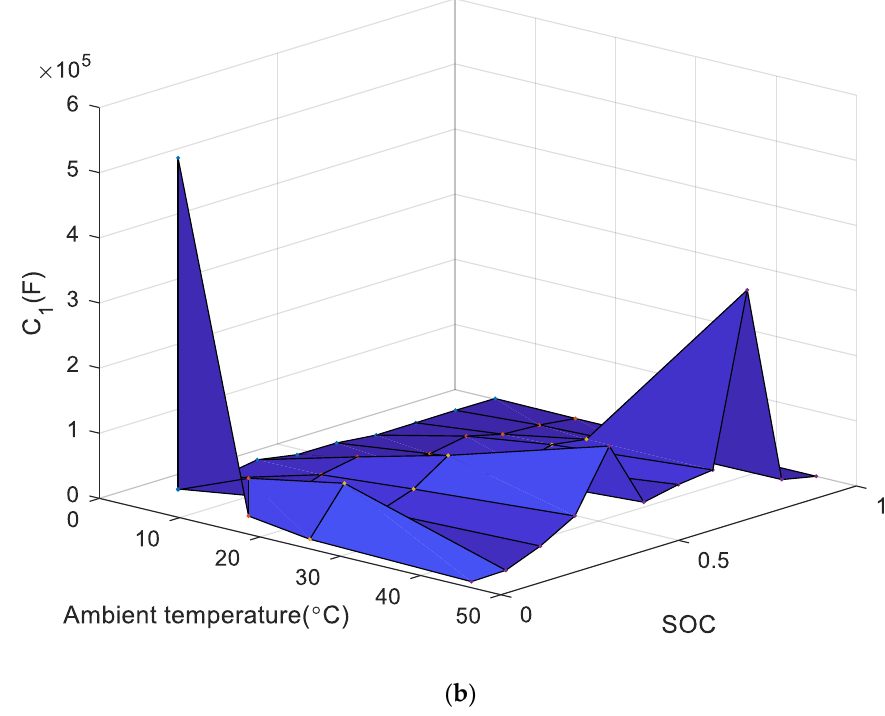
Figure 10. C 1 as a function of ( a ) SOC ; ( b ) SOC and ambient temperature.